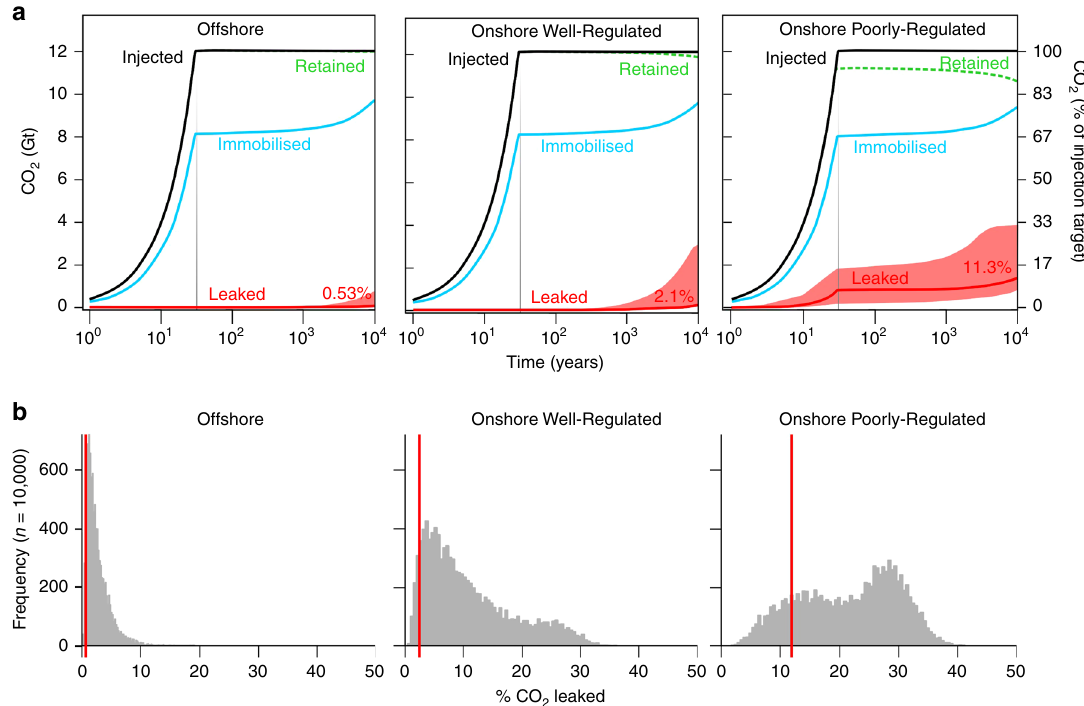
Fig. 3 CO 2 storage modelling results for the three target scenarios. a Evolution of CO 2 immobilisation and leakage over time, for the three base case scenarios. The black line shows the total CO 2 injected, between 2020 and 2050. The grey line shows when injection ceases. The blue line shows CO 2 retained by immobilisation due to rapid residual trapping and due to longer-timescale solubility and mineralisation trapping. The green dashed line is the cumulative limit of CO 2 retention due to leakage of CO 2 out of the subsurface, for example through faults or leaking wells, and is the inverse of leakage (red line). Between the blue and green lines is CO 2 retained in the reservoir by structural/stratigraphic trapping. Most CO 2 loss occurs through leaking wells. Red line at base of graph shows the base case result of cumulative leakage through time, with shaded P5 to P95 distribution envelopes above and below as derived from Monte Carlo analysis. The red number is the base case percentage cumulative leakage at 10,000 years, cf Table 1. b Histograms showing the distribution of results from Monte Carlo analysis (10,000 realisations) for each scenario; results are cumulative leakage as a percentage of the total CO 2 injected at model year 10,000 ( x -axis). Red vertical lines show the base case scenario cumulative leakage result at 10,000 years (red numbers in